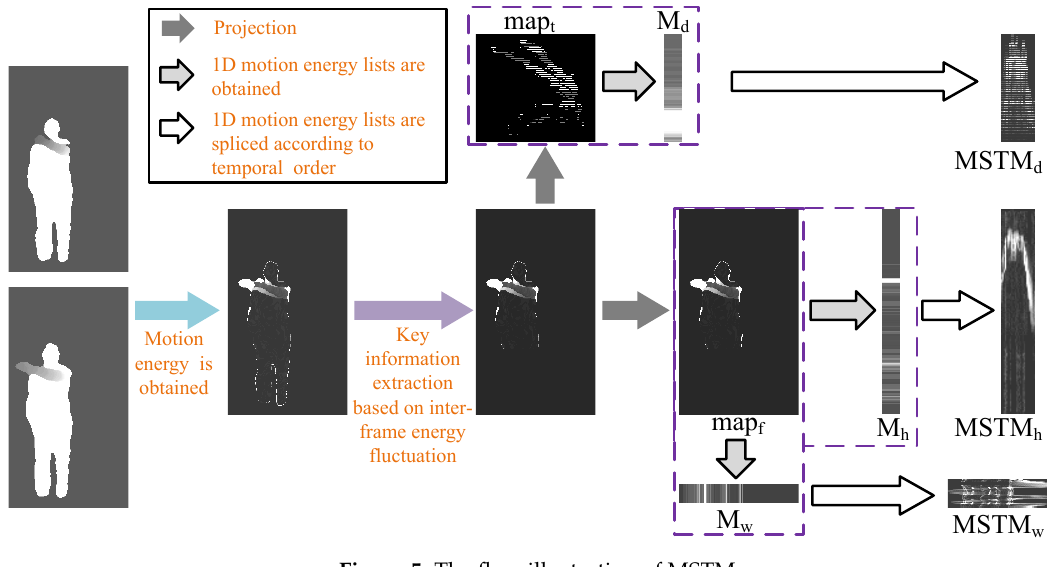
Figure 5. The flow illustration of